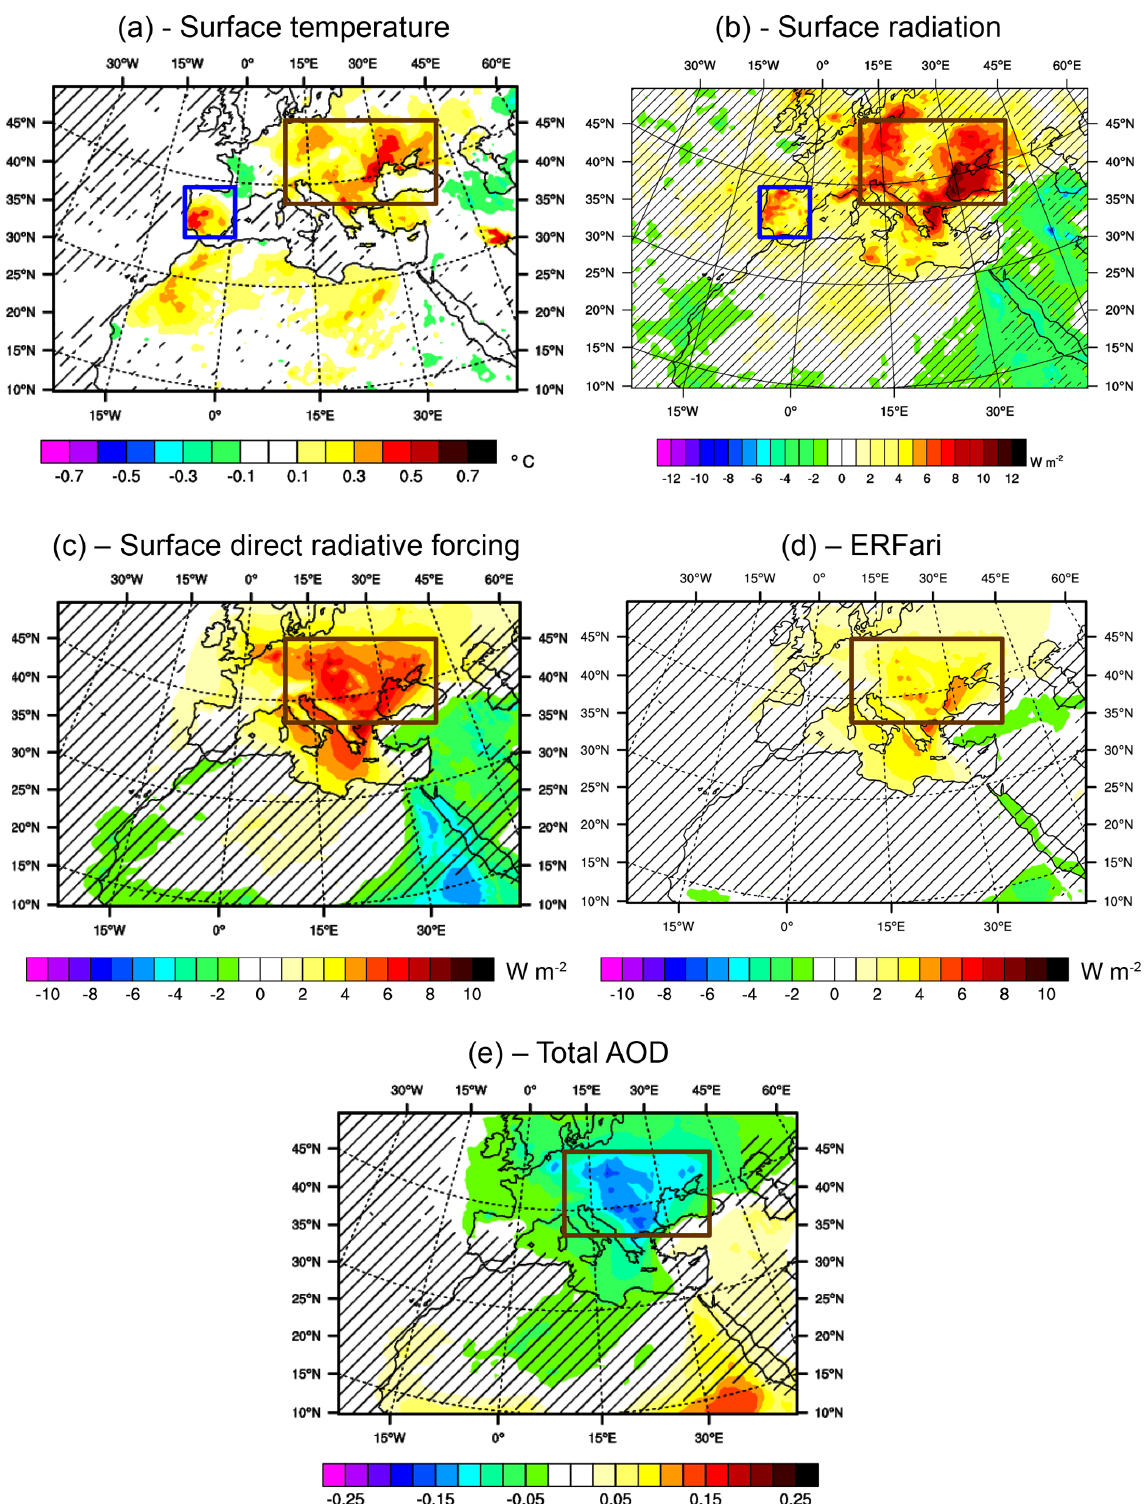
Figure 13. Mean differences for the months of June, July and August between SSP585 and SSP585cst simulations over the period 2021–2050 for the surface temperature ( ◦ C, a ), the surface radiation (Wm − 2 , b ), the surface direct radiative forcing (Wm − 2 , c ), the effective radiative forcing due to aerosol–radiation interactions (ERFari,Wm − 2 , d ) and the total AOD (e) . The brown frame represents Central Europe and the blue frame locates the Iberian Peninsula. The hatched areas are statically non-significant with a threshold of